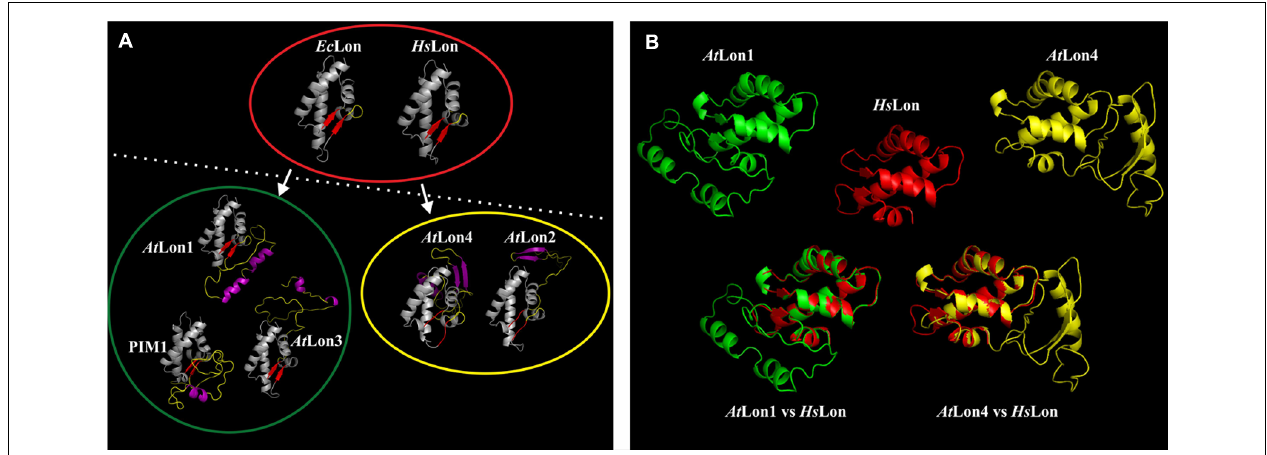
FIGURE 3 | Molecular modeling provides insights into the structural features of Arabidopsis Lon proteases. (A) Monomer structure comparison of the ribbon model of the sensor- and substrate-discrimination (SSD) domain discriminates the hexameric bacterial and human Lon complexes encompassed by red eclipse from possibly heptameric complexes of Pim1 and Arabidopsis Lon homologs. On the basis of discrete structural features the Arabidopsis proteases could be further categorized into two groups encompassed by green and yellow eclipses.The Lon protein accessions and the coordinates of the SSD domains given in parentheses are At Lon1: NP_568490 (603–739), At Lon2: NP_568675 (547–784), At Lon3: